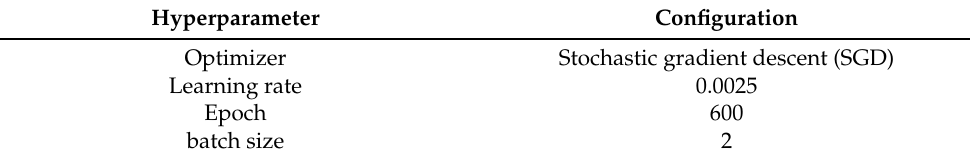
Table 1. Hyperparameter